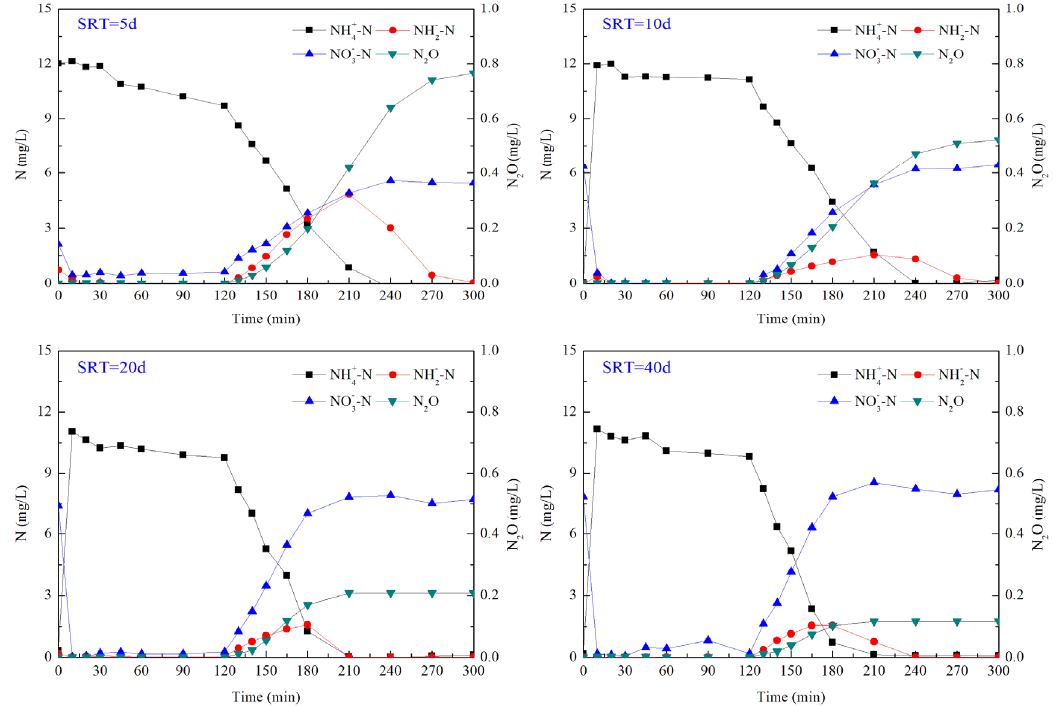
Figure 3. Dynamics of nitrogen in typical batch SBR cycles at different